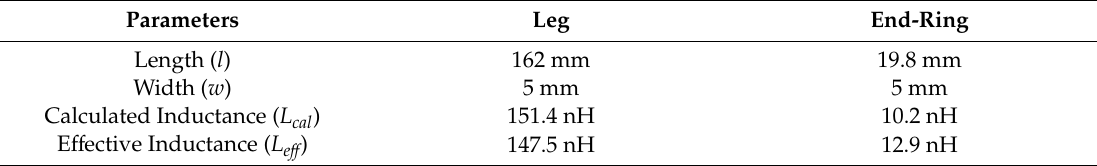
Table 1. Birdcage coil segments dimensions and inductances.